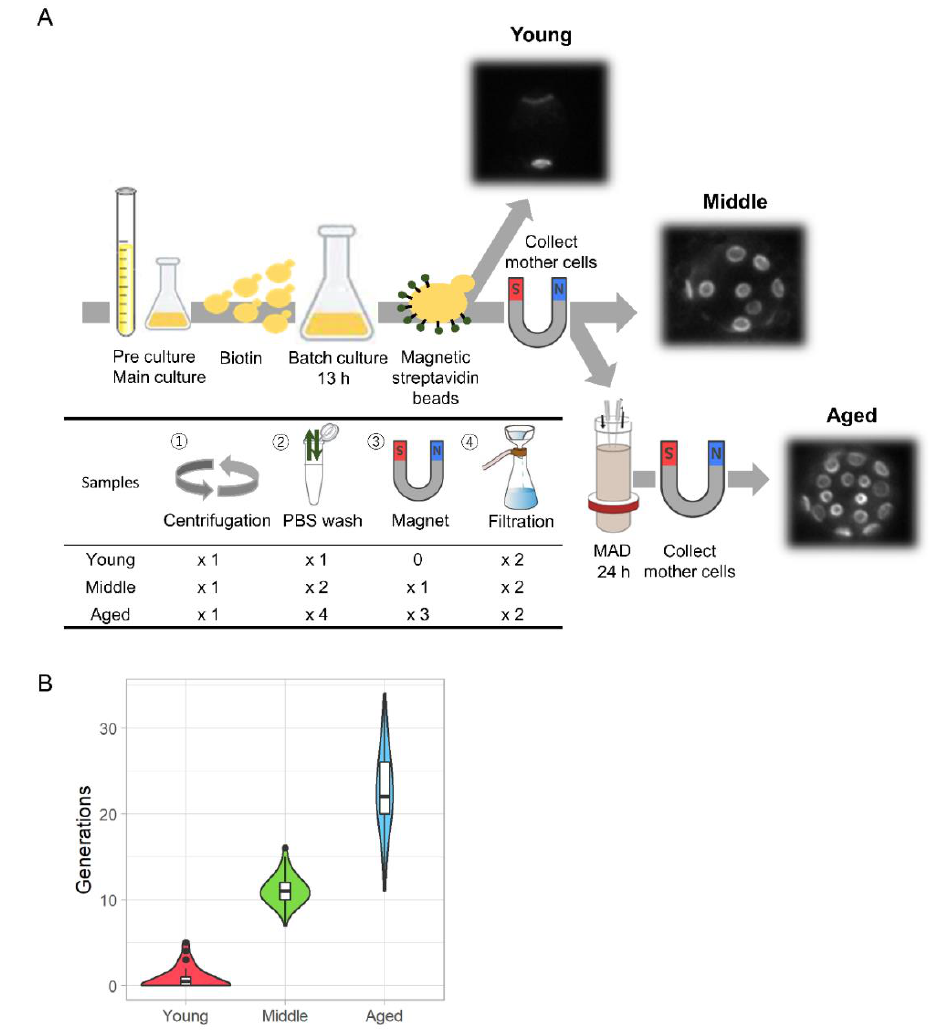
Figure 1. Outline of the experiments. ( A ) Young, Middle, and Aged cells were collected from MAD for RNA-Seq and ribosome profiling experiments. Grey arrows indicate workflows. Yeast cells were treated with EZ-Link Sulfo-NHS-LC-LC-Biotin, collected, and batch-cultured in flasks at 25 °C for 13 h. Middle-aged mother cells were bound to magnetic streptavidin beads, then collected with a magnet (Middle). Supernatant containing the daughter cell fraction was also collected (Young). MAD loading and MAD operation were performed in the vessel associated with the magnet and incubated for an additional 24 h. Finally, the beaded aged cells were collected and purified with a magnet (Aged). The numbers of centrifugations, PBS washes, magnet operations, and filtrations are shown in the inset table. Efforts were made to minimize differences in conditions among samples. ( B ) Distribution of mother cell ages estimated from the numbers of bud scars. Bud scars were counted via staining with wheat germ agglutinin conjugated to Alexa Fluor 488 for 30 min, then observation under a fluorescence microscope. 2.3. Cell Harvest Yeast cells were collected on 0.45 μm pore size membrane filters (Millipore, Cat. # HAWP04700) via filtration, immediately removed with a cell scraper (TPP, Cat. # 99002, TPP Techno Plastic Products AG, Trasadingen, Schaffhausen, Switzerland), then placed into Nunc 50 mL conical sterile polypropylene centrifuge tubes (Thermo Fisher Scientific, cat. No. 339652) containing liquid nitrogen. Then, 0.6 mL lysis buffer (20 mM Tris-HCl pH 7.5 (Wako Pure Chemical Industries, Ltd., Cat. # 318-90225, Wako Pure Chemical Indus- tries, Ltd., Osaka, Japan), 150 mM NaCl (Nacalai Tesque, Cat. # 06900-14, NACALAI TESQUE, Inc., Kyoto, Japan), 5 mM MgCl2 (Nacalai Tesque, Cat. # 20942-34), 1 mM